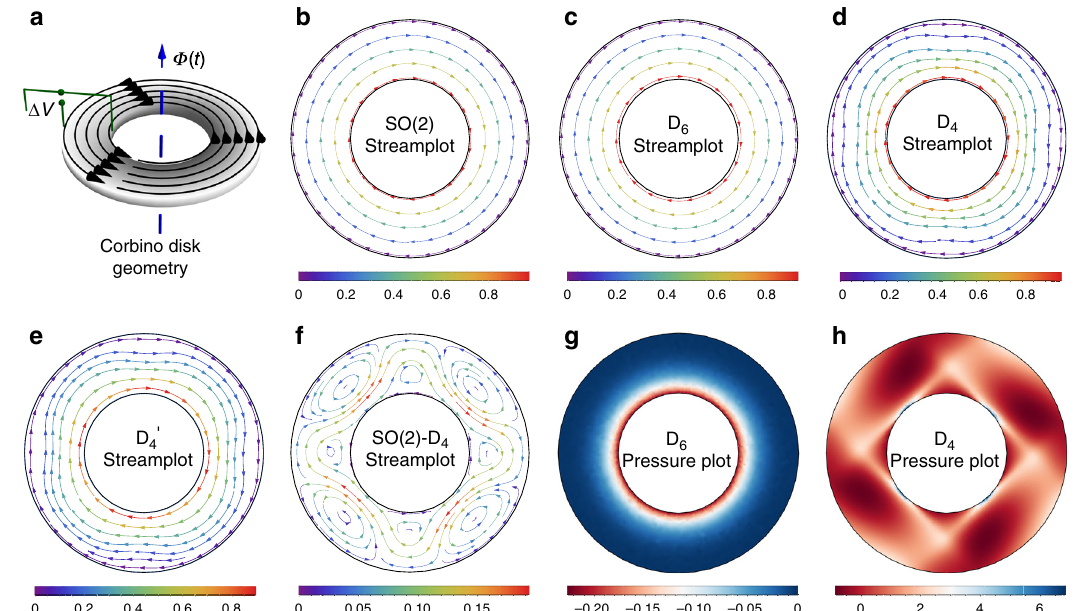
Fig. 1 Effect of viscosity tensor anisotropy on rotational fl ow in an annulus. a Corbino disk geometry schematic. The time-varying magnetic fl ux, Φ ( t ), acting on a voltage drop, Δ V , gives rise to a Lorentz force, inducing rotational electron fl ow. b Steady-state streamplot plot using an isotropic (SO(2)) viscosity tensor. Streamplots using c hexagonal ( D 6 ), and d square ( D 4 ) viscosity tensors. e Streamplot using square ( D 4 ) viscosity tensor, allowing for momentum-relaxing body force terms equal to ∣ R ∣ L 2 / ∣ A ∣ = 0.1. f Difference in steady-state streamplot between isotropic and D 4 viscosity tensors, highlighting the emergence of steady-state vortices. Steady-state pressure plot using g D 6 and h D 4 viscosity tensors, illustrating the breaking of azimuthal symmetry in the latter. Color scales indicate the magnitude of the velocity vector fi eld ( b – f ) and pressure fi eld ( g , h